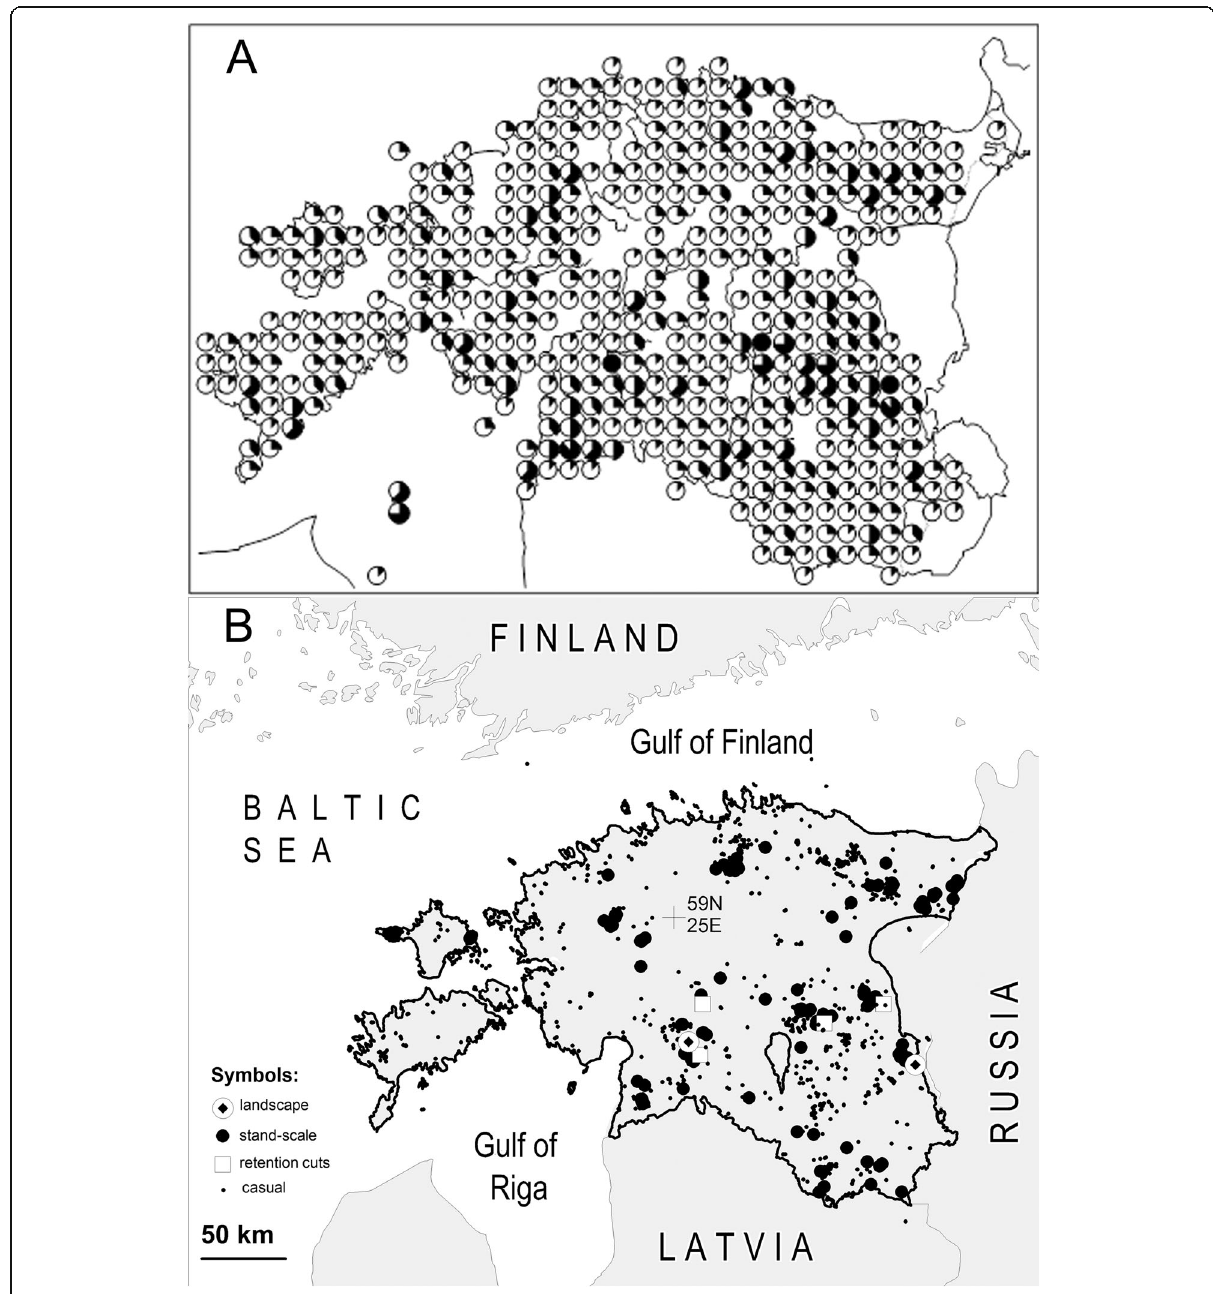
Fig. 1 Distribution of the Estonian polypore datasets included in this study. a Data until 2004: relative no. of species of the total species pool on the 10 × 10 km UTM-grid as reported by Parmasto (2004). b Systematic surveys and casual records in 2005 – 2018. ‘ Landscape ’ surveys refer to intensive sampling of the Soomaa area in the west (Runnel et al. 2015 and unpubl.) and Aravu area in the east (Lõhmus 2011). ‘ Stand-scale ’ surveys are standard-effort surveys in 2-ha plots (Lõhmus et al. 2018a). ‘ Retention-cut ’ sampling was from selected trunks (Runnel et al. 2013). Casual records are all other records and observations extracted from PlutoF database, 8 November 2018. Graph (A) reproduced with the permission of the Estonian University of Life Sciences,